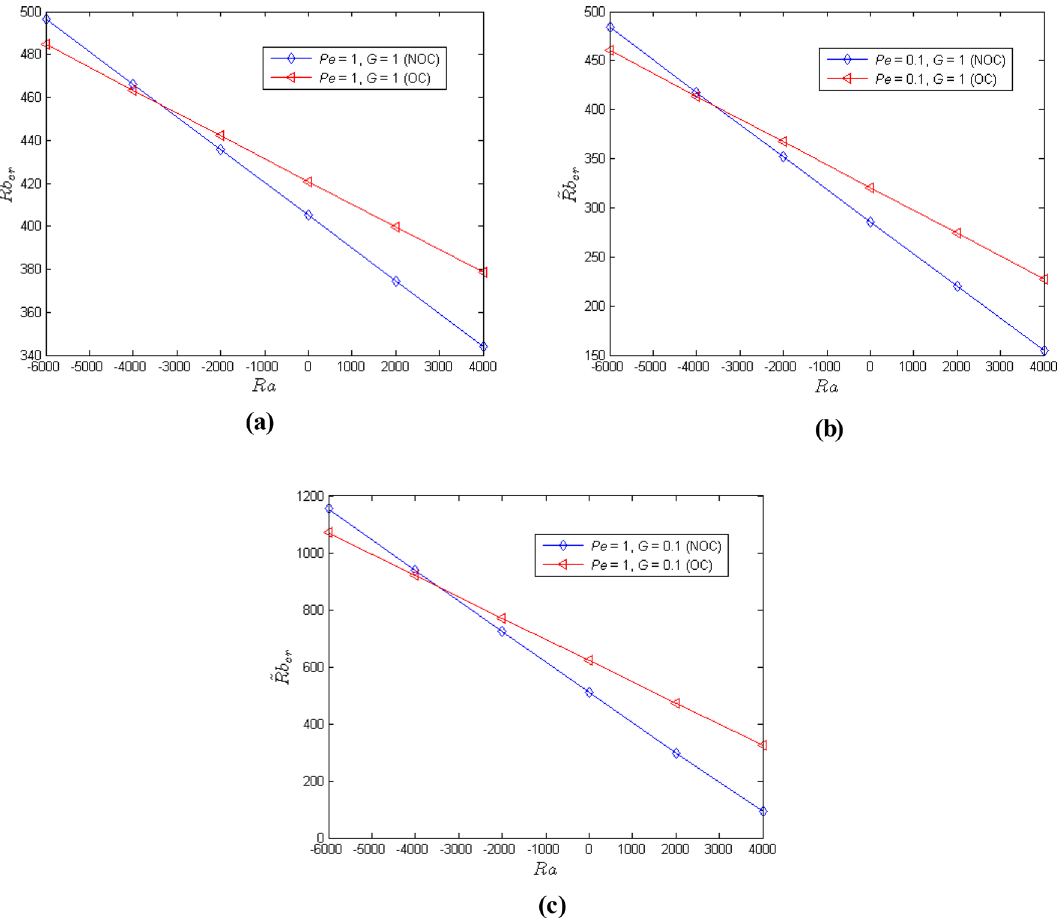
Fig. 2 The case of rigid lower and stress free upper surfaces: a – c Boundaries of Stationary and oscillatory instability modes of convections in ̃ Rb the ( Ra , cr ) plane for varying values of Péclet number